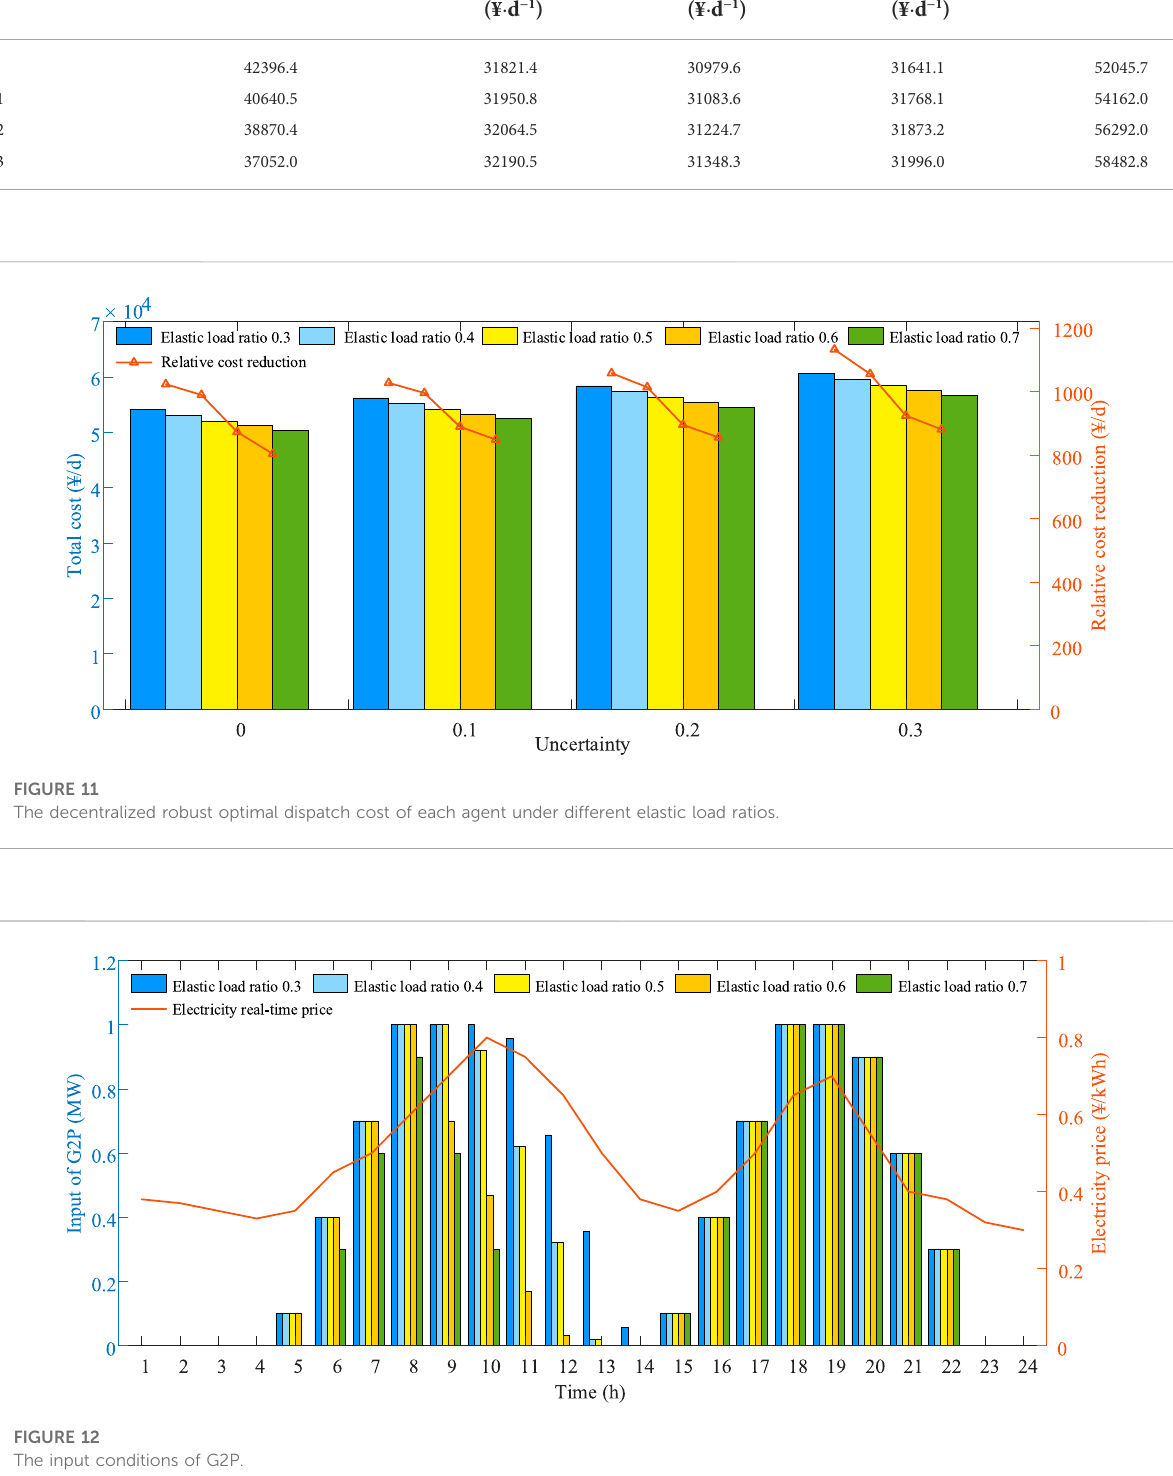
FIGURE 12 The input conditions of